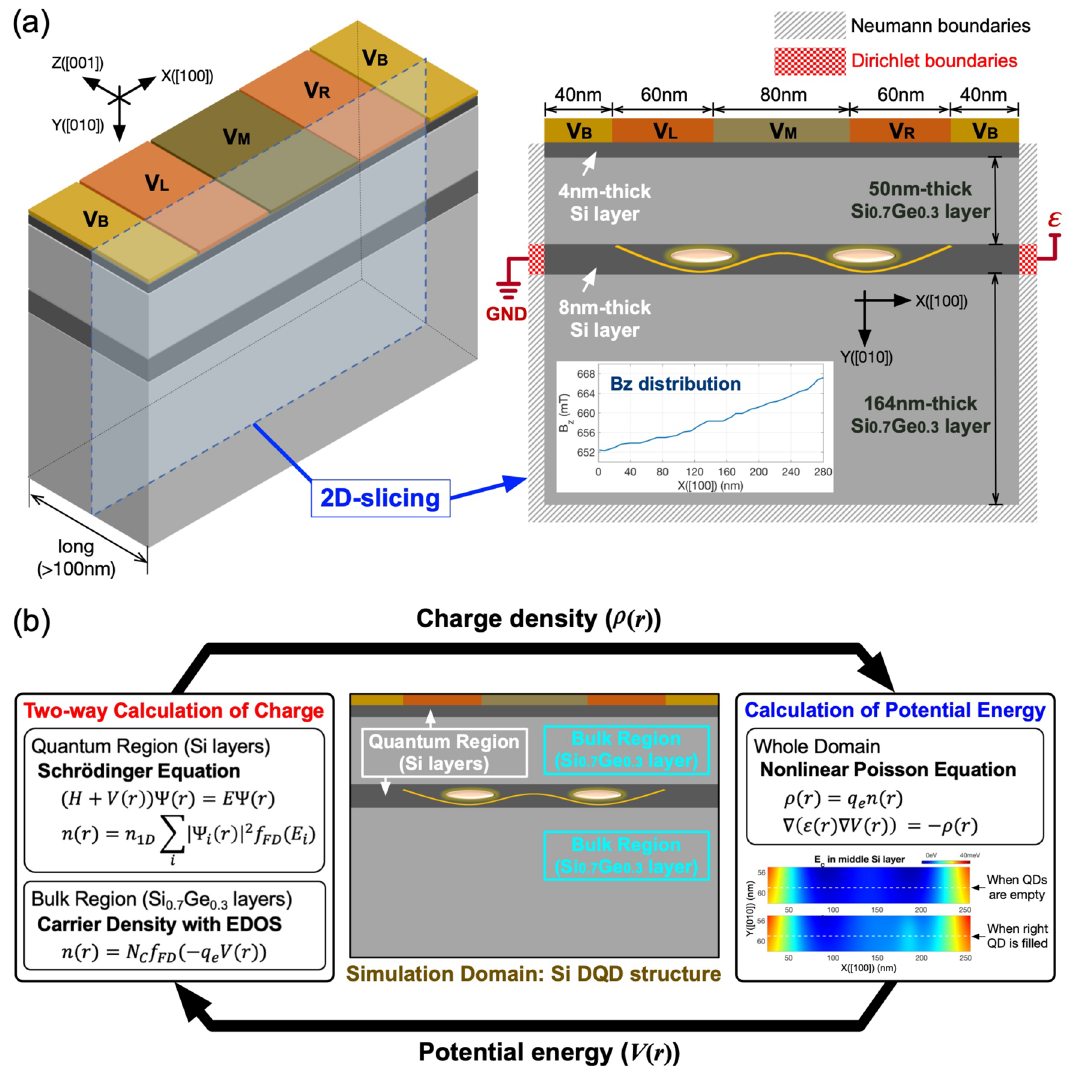
Figure 1. Target structure and multi-scale scheme of device modeling. ( a ) A 3D view of the silicon (Si) double quantum dot (DQD) structure that resembles the physical one reported by Zajac et al. (Ref. 10 ). Here the lateral confinement (along the [100] direction) is controlled with DC biases imposed on the top electrodes, while the vertical one (along the [010] direction) is naturally formed due to the band offset among silicon-germanium (SiGe) and Si layers. Since the structure is very long along the [001] direction, we use its 2D slice for device simulations assuming it is infinitely long along that direction (a lateral distribution of the static magnetic field B Z , generated from a horseshoe-shaped cobalt micromagnet, is shown in the inset). ( b ) The self-consistent loop of device simulations used to model spatial distributions of charge and potential. Here the charge distribution at a given potential distribution is obtained in two ways; the electronic structure simulation based on a parabolic effective mass model is used to get the density in Si layers where most of electrons reside, while the region of SiGe layers is treated with the physics of bulk Representing the strength of inter-QD qubit interaction, the exchange energy ( J ) between two ground states serves as a source of 2-qubit entanglement in the DQD platform and can be controlled with the middle gate bias that affects the potential barrier between two QDs. In our simulations, J becomes 75.6 KHz at V M = 400 mV (at Pinit ) and, as shown in Fig. 3b, sharply reaches 19.3 MHz when V M is increased by 8 mV. Changes in V M also affect Zeeman-splitting energies of the left ( E ZL ) and the right ground state ( E ZR ) that determine the resonance frequency of each spin qubit, but their dependence on V M is not quite noticeable such that ( E ZL , E ZR ) is (18.309 GHz, 18.453 GHz) at V M = 400 mV and changes to (18.312 GHz, 18.448 GHz) when V M is 408 mV. Due to the laterally inhomogeneous B Z (the inset of Fig. 1a), E ZL and E ZR are distinguishable and qubits can be addressed independently if their interaction is weak, and one of such cases is shown in Fig. 3c, where we simulated 2-qubit responses at V M = 400 mV with a [010]-oriented time-varying magnetic field B Y ( t ) = B o cos (ω D t + θ) that is generated from a microwave pulse and is incorporated in modeling as elements of the Heisenberg Hamiltonian. In particular, the two subfigures here show that a R Y (π) operation (1-qubit rotation by π radian around the